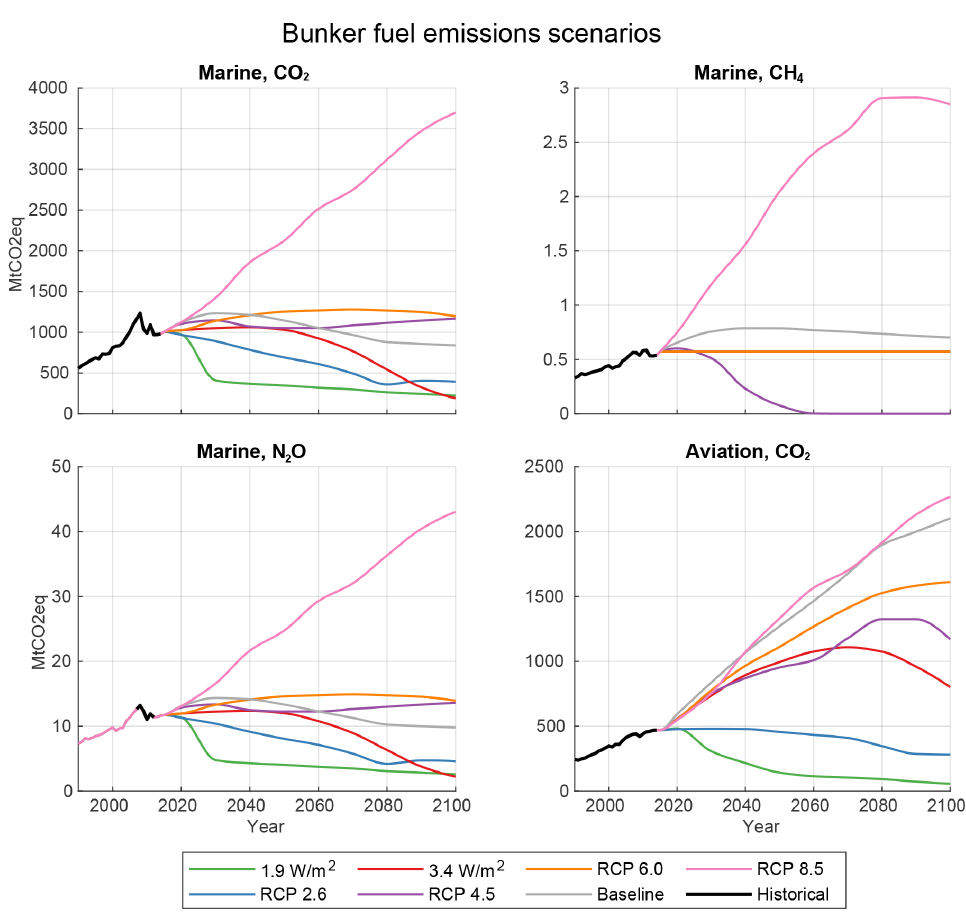
Figure 4. Scenarios for bunker fuels used to remove bunker emissions from the RCP and SSPv2 emission scenarios. Aviation emissions are only available for CO 2 . Historical data are from CMIP6 (Hoesly et al., 2018) for CO 2 and CH 4 . For N 2 O we use data from the Interna- tional Maritime Organization (IMO) and EDGAR v4 . 3 . 2 data (Emissions Database for Global Atmospheric Research; JRC and PBL, 2017; Janssens-Maenhout et al., 2019) for the time not covered by the IMO